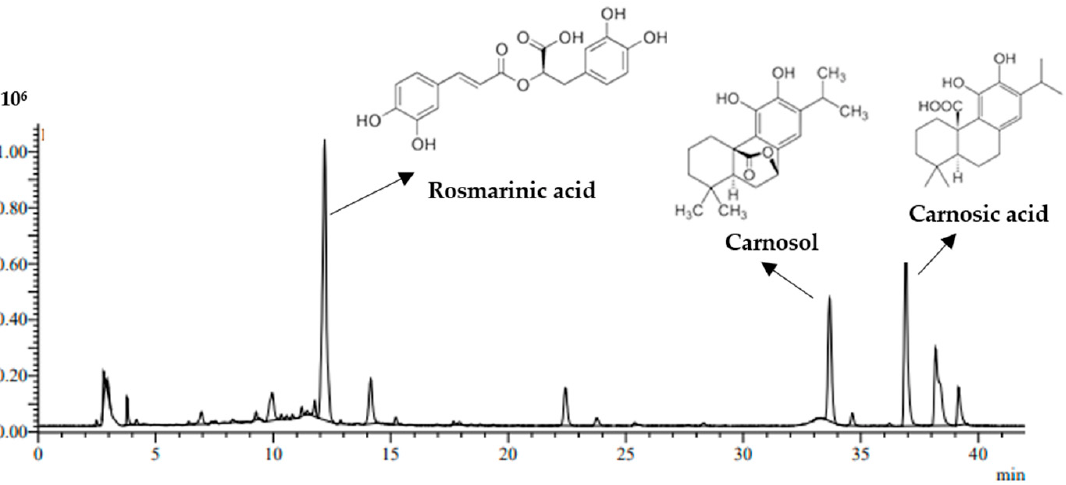
Figure 1. TIC profile of sage solid residue extract with the chemical structures of rosmarinic acid, carnosic acid, and carnosol, recorded in the negative ion mode for UAE under optimized conditions.